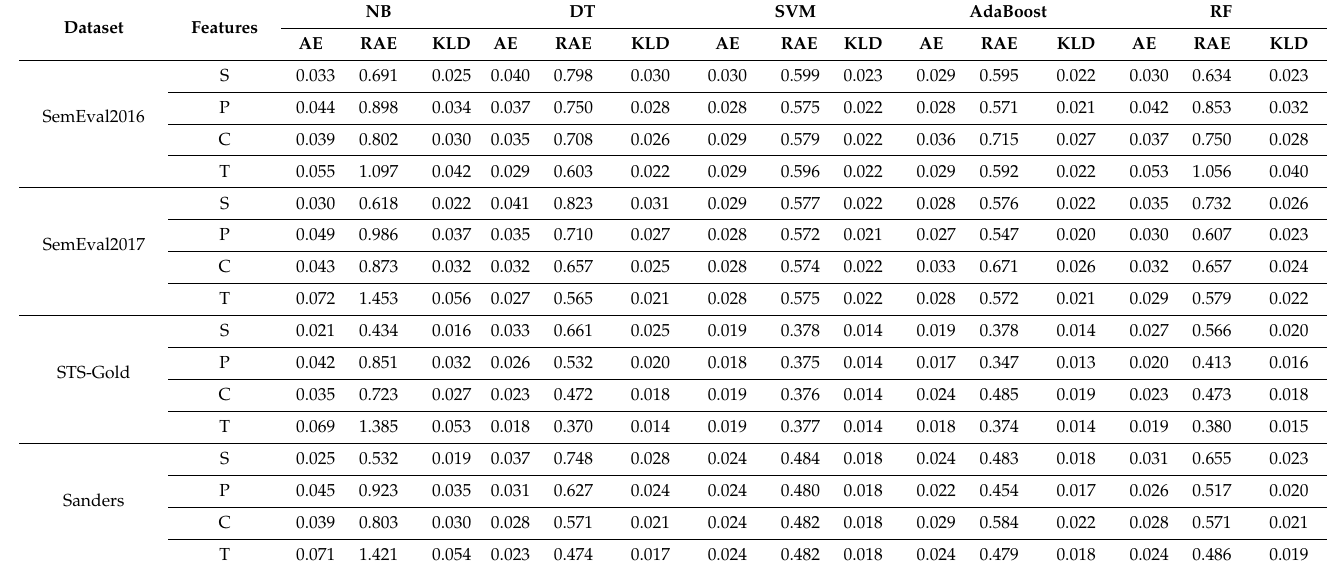
Table 5. Comparison of single feature sets using ML